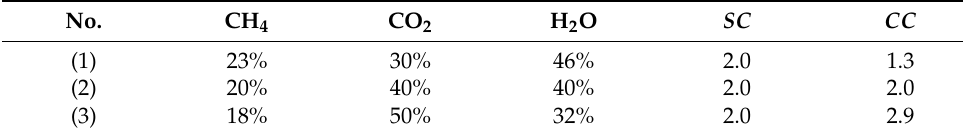
Table 3. Variants of the inlet gas compositions.